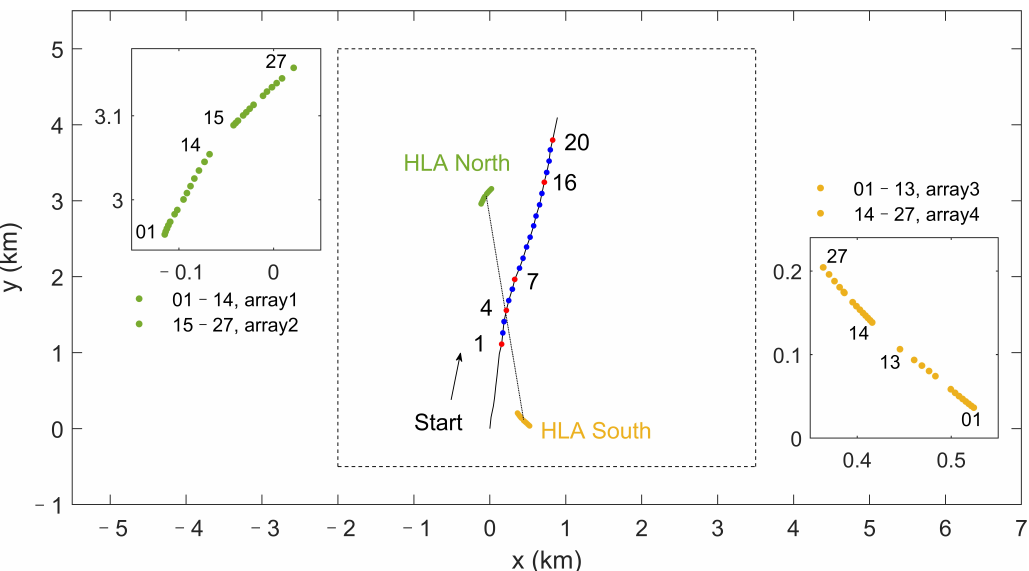
Figure 1. (Color online) Geometric plot of the 27-element subsets of the two horizontal line arrays and the source track for Event S5. Filled green and yellow circles indicate the north large array (HLA North) and the south large array (HLA South), respectively. The four small-aperture arrays 1 to 4 are indicated by element indices. Dashed black line connects the center of the two HLAs. Solid black line indicates the source track for the first 30 min. Filled blue circles indicate true source positions for the 19 min data processed, and filled red circles mark several key points along the track. Dashed box indicates the 2D search